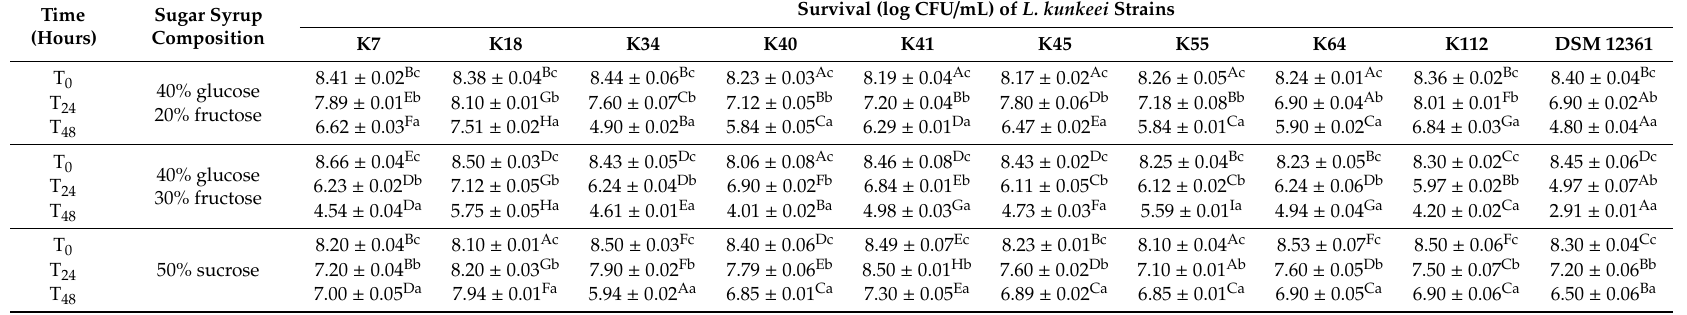
Table 2. Survival of the L. kunkeei strains in di ff erent sugar syrups after 24 and 48 h of incubation at 20 ◦ C. Results are shown as mean ± standard deviation (n = 3). For every sugar syrup, di ff erent lowercase letters (a-c) indicate significant di ff erences in columns, and di ff erent uppercase letters (A-I) indicate significant di ff erences in rows ( p <